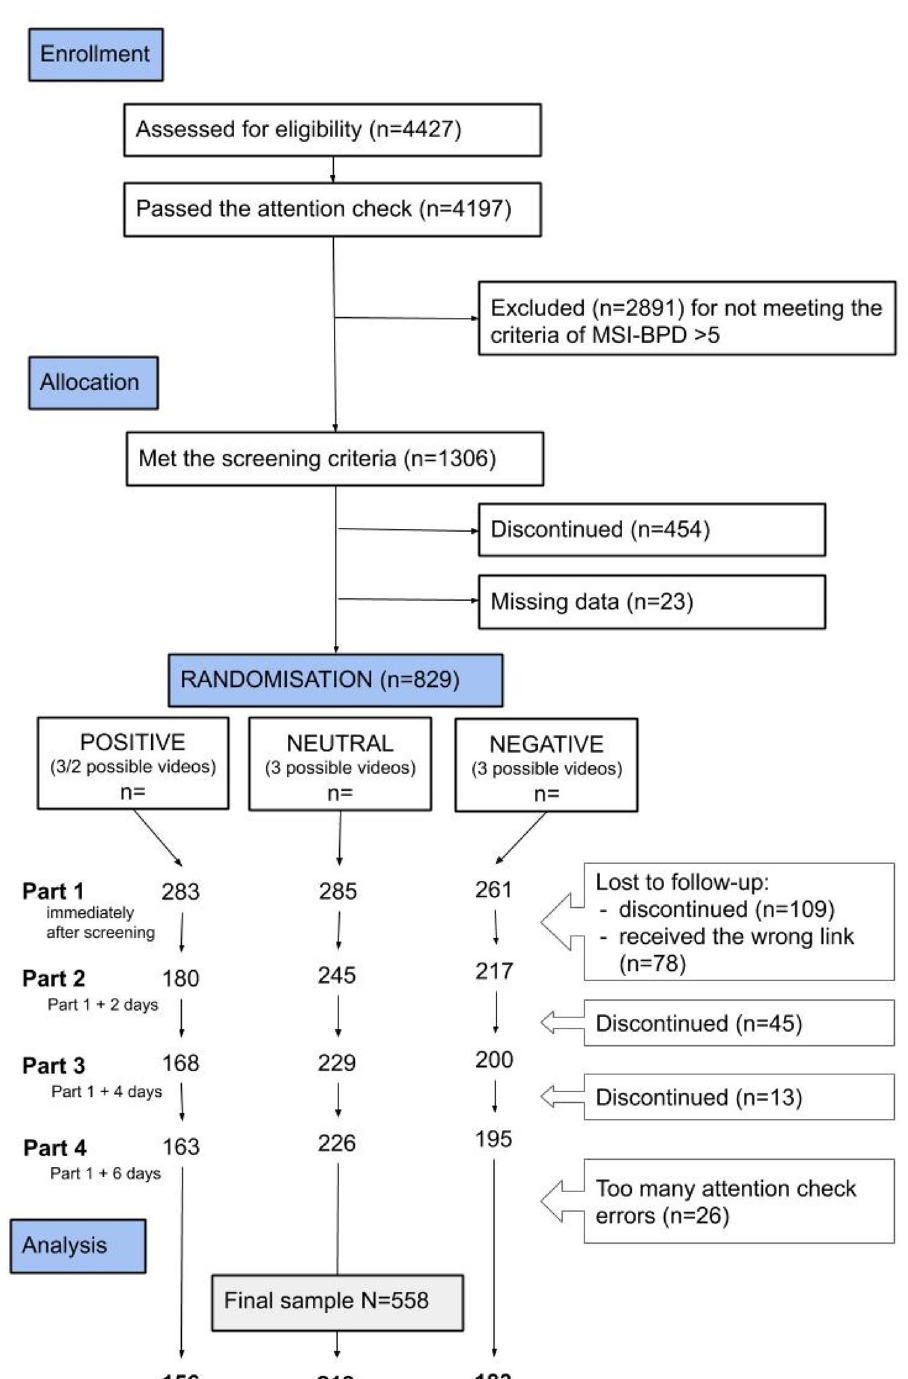
Figure 1. Participant flow chart. Note : The figure shows the study design and the number of participants at each stage of the study. In Part 1, participants’ mood was assessed. Participants watched a video clip (which could be positive, neutral, or negative, selected randomly) and filled out questionnaires regarding their general impression and more detailed impression of the character (PANAS). Finally, BPD status was assessed. Only mood, general impression, and detailed impression were assessed during Parts 2, 3, and 4, which took place at intervals of 2